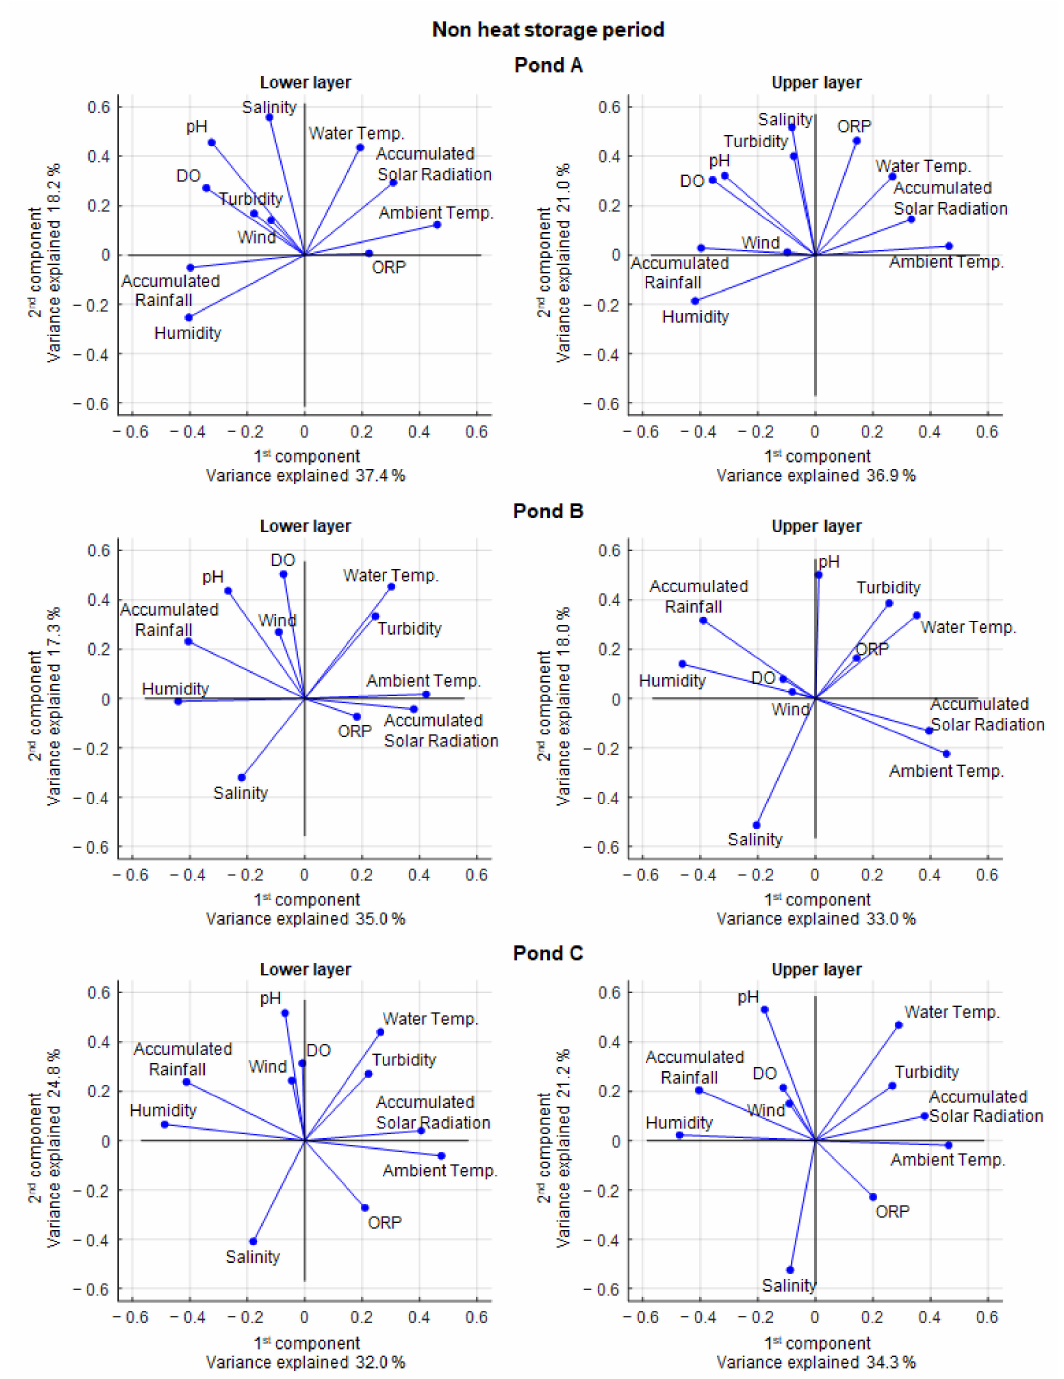
Figure 14. Biplot of PCA scores for the non-heat storage